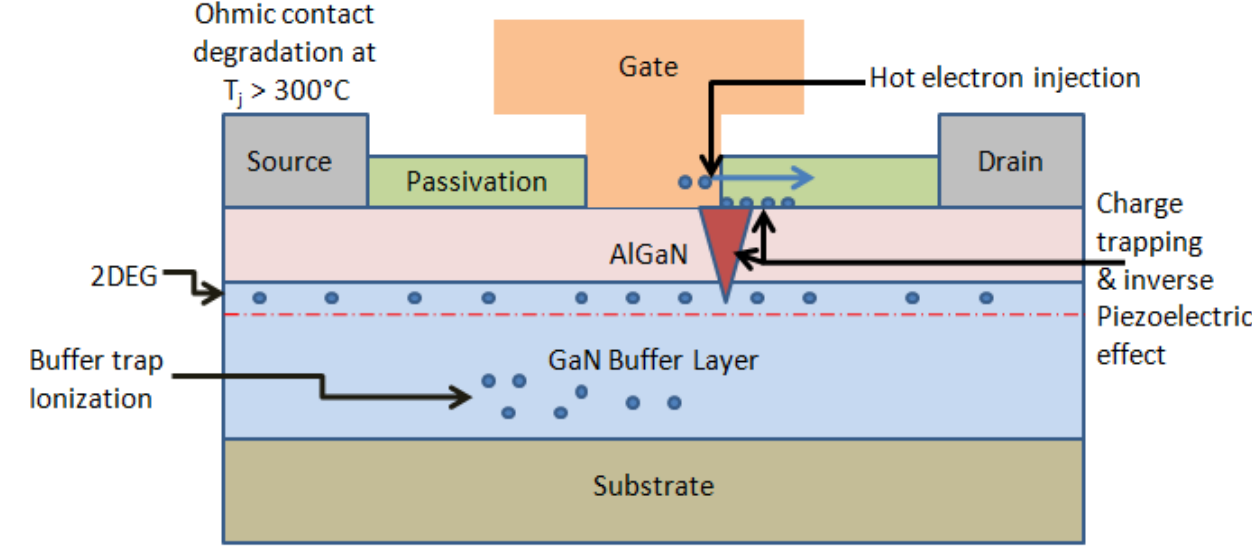
Figure 3. Schematic of degradation mechanisms in AlGaN/GaN